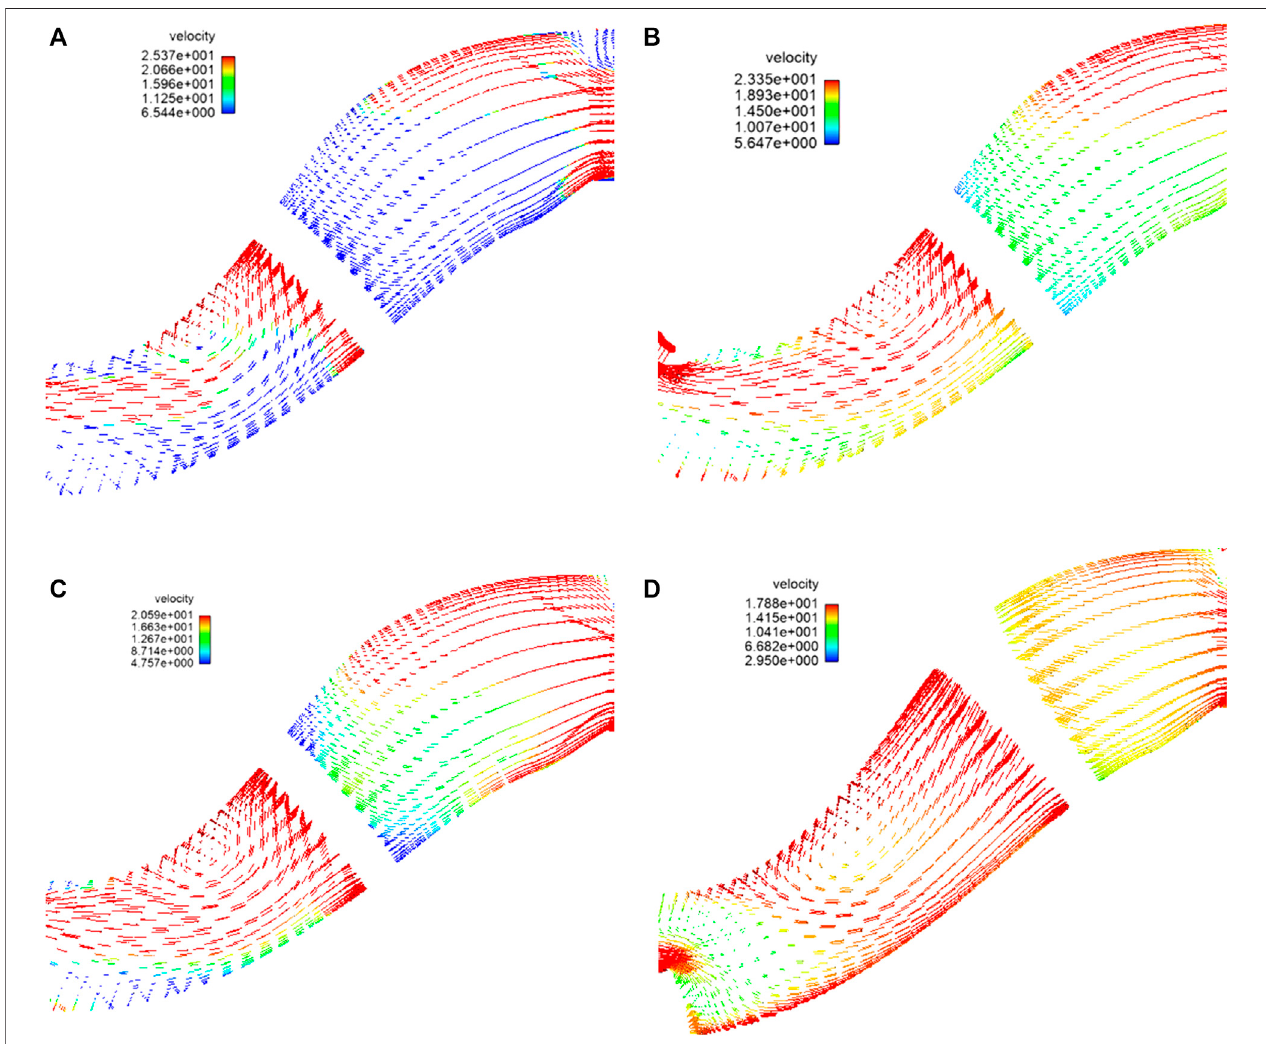
FIGURE 6 | Distribution of the secondary fl ow in the space guide vane: (A) 1,100 rpm, (B) 1,200 rpm, (C) 1,300 rpm, and (D) 1,450 rpm.